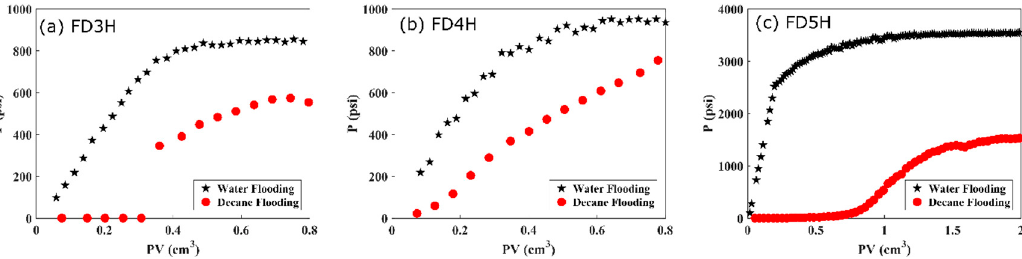
Figure 3. Pressure P (psi) during decane and water flooding as a function of pore volume PV (cm 3 ) injected.